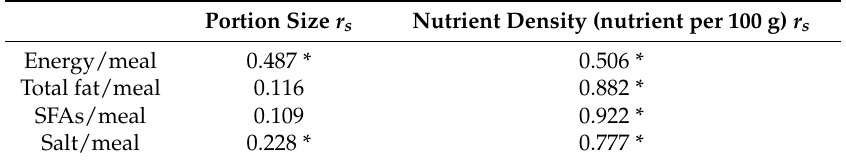
Table 3. Correlation between nutrient density, portion size, and nutrient content of the